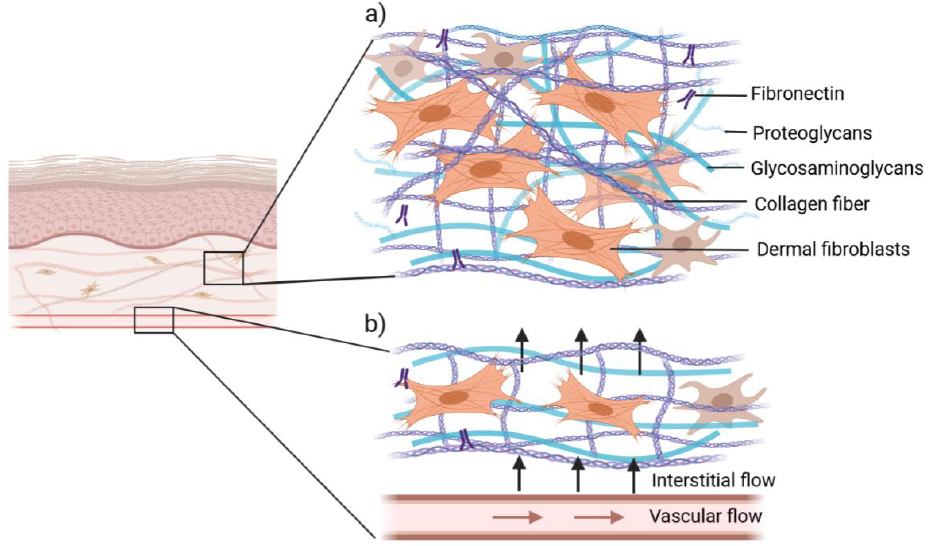
Figure 3. Extracellular matrix (ECM) in vivo skin. ( a ) Schematic of the dermal matrix showing dermal fibroblasts surrounded by the components of typical ECM, composed of collagens, glycosaminoglycans, proteoglycans and fibronectin. These components are secreted and remodeled by the fibroblasts, which results in an organized meshwork. ( b ) Schematic of the interstitial flow. The interstitial flow provides convection necessary for transport of molecules through the ECM or interstitium and induces morphogenic effects in dermal